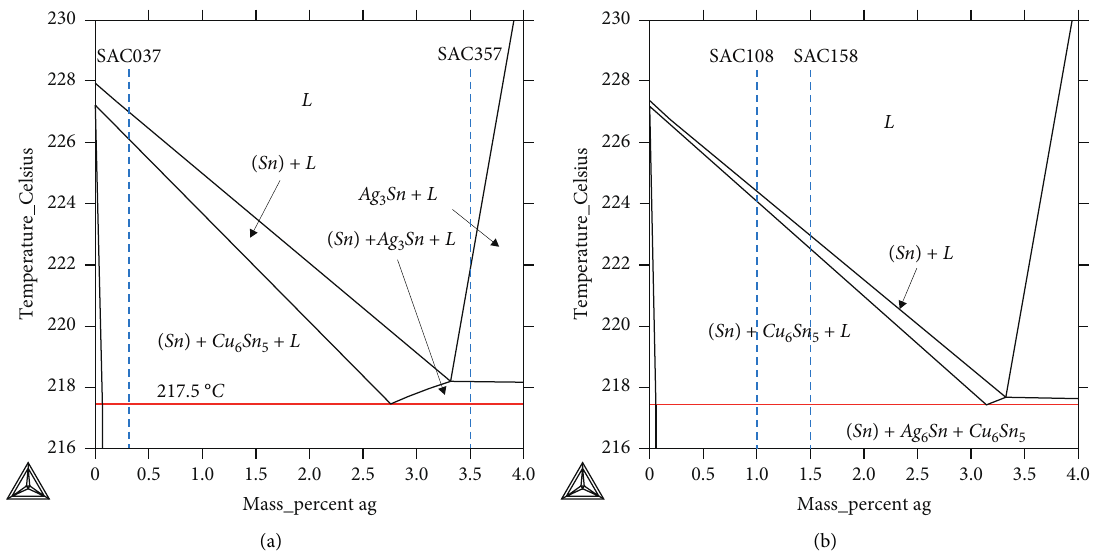
Figure 6: Vertical section diagrams of Sn-0.7Cu-xAg (a) and Sn-0.8Cu-xAg (b) ternary systems.